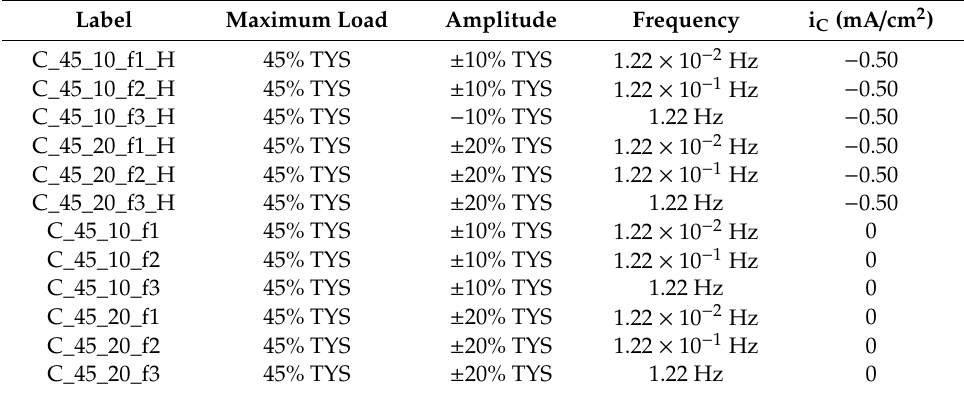
Table 2. Test conditions for the evaluation of the e ff ect of cyclic loading on the hydrogen stationary permeation flux and the passivity current.